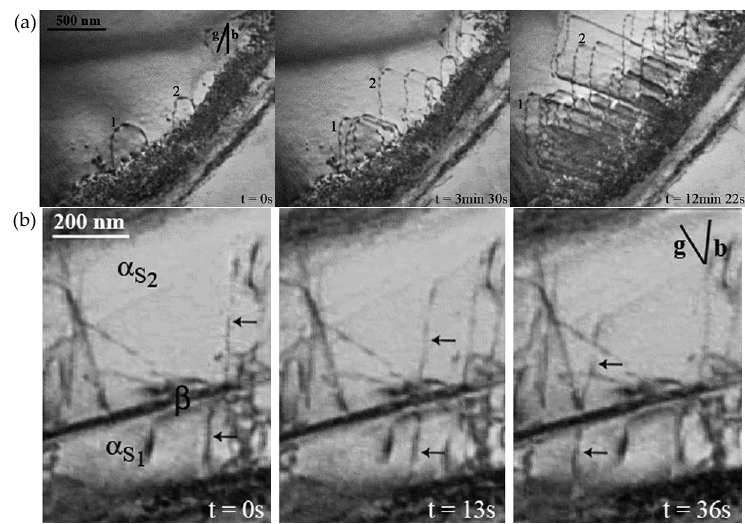
Figure 11. ( a ) In situ TEM observation of the dislocation emission from α p /β interface; ( b ) in situ sequence showing simultaneous slip of dislocations in two α s laths and one β lath [99].